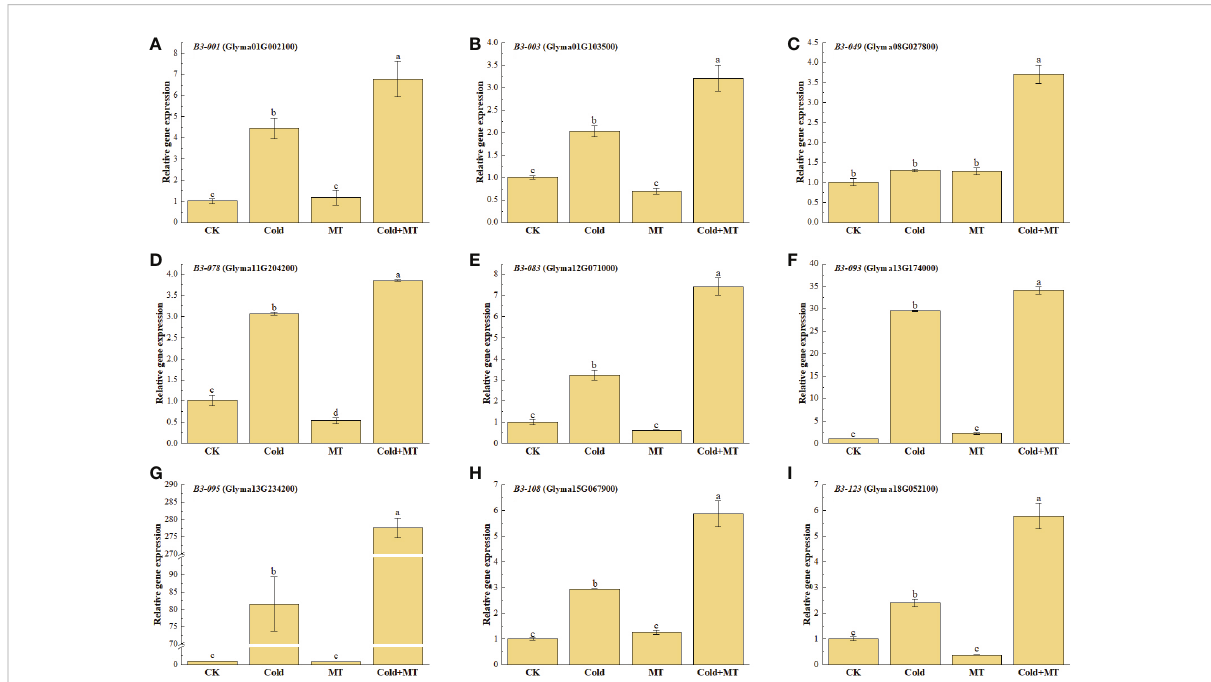
FIGURE 3 Effects of exogenous melatonin treatment on the expression of B3 genes in soybean. (A) GmB3-001 expression. (B) GmB3-003 expression. (C) GmB3-049 expression. (D) GmB3-078 expression. (E) GmB3-083 expression. (F) GmB3-093 expression. (G) GmB3-095 expression. (H) GmB3- 108 expression. (I) GmB3-123 expression. Error bars represented the standard deviation (SD; n = 3). According to Duncan's multiple tests, bars with different letters were signi fi cantly different (p <